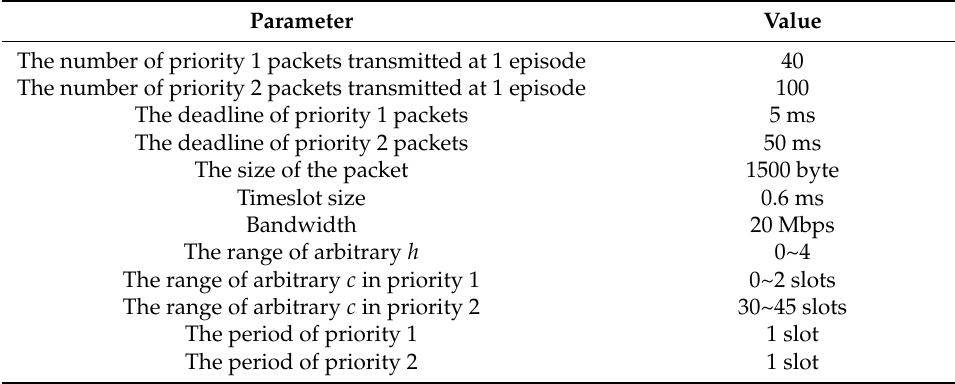
Table 4. Network parameters for training the